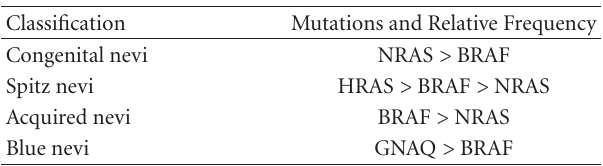
Table 5: Summary of common mutations found in congenital, spitz, acquired, and blue